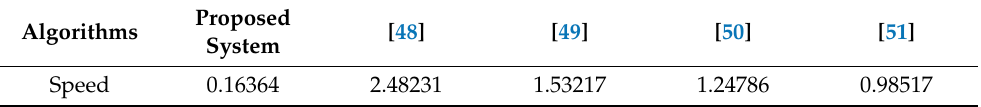
Table 8. Computational